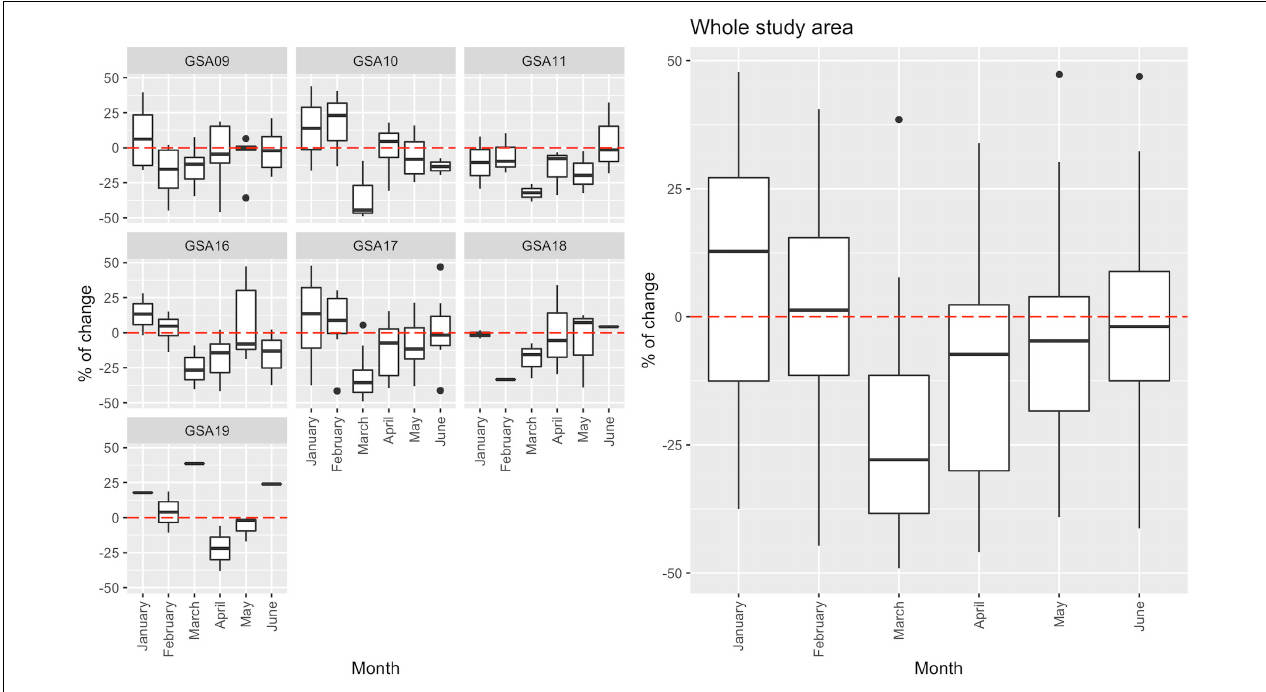
FIGURE 8 | Boxplot showing the variation (as percentages comparing values of the year 2020 and those of the 2019) in the total monthly landings of demersal species in the main harbors for each